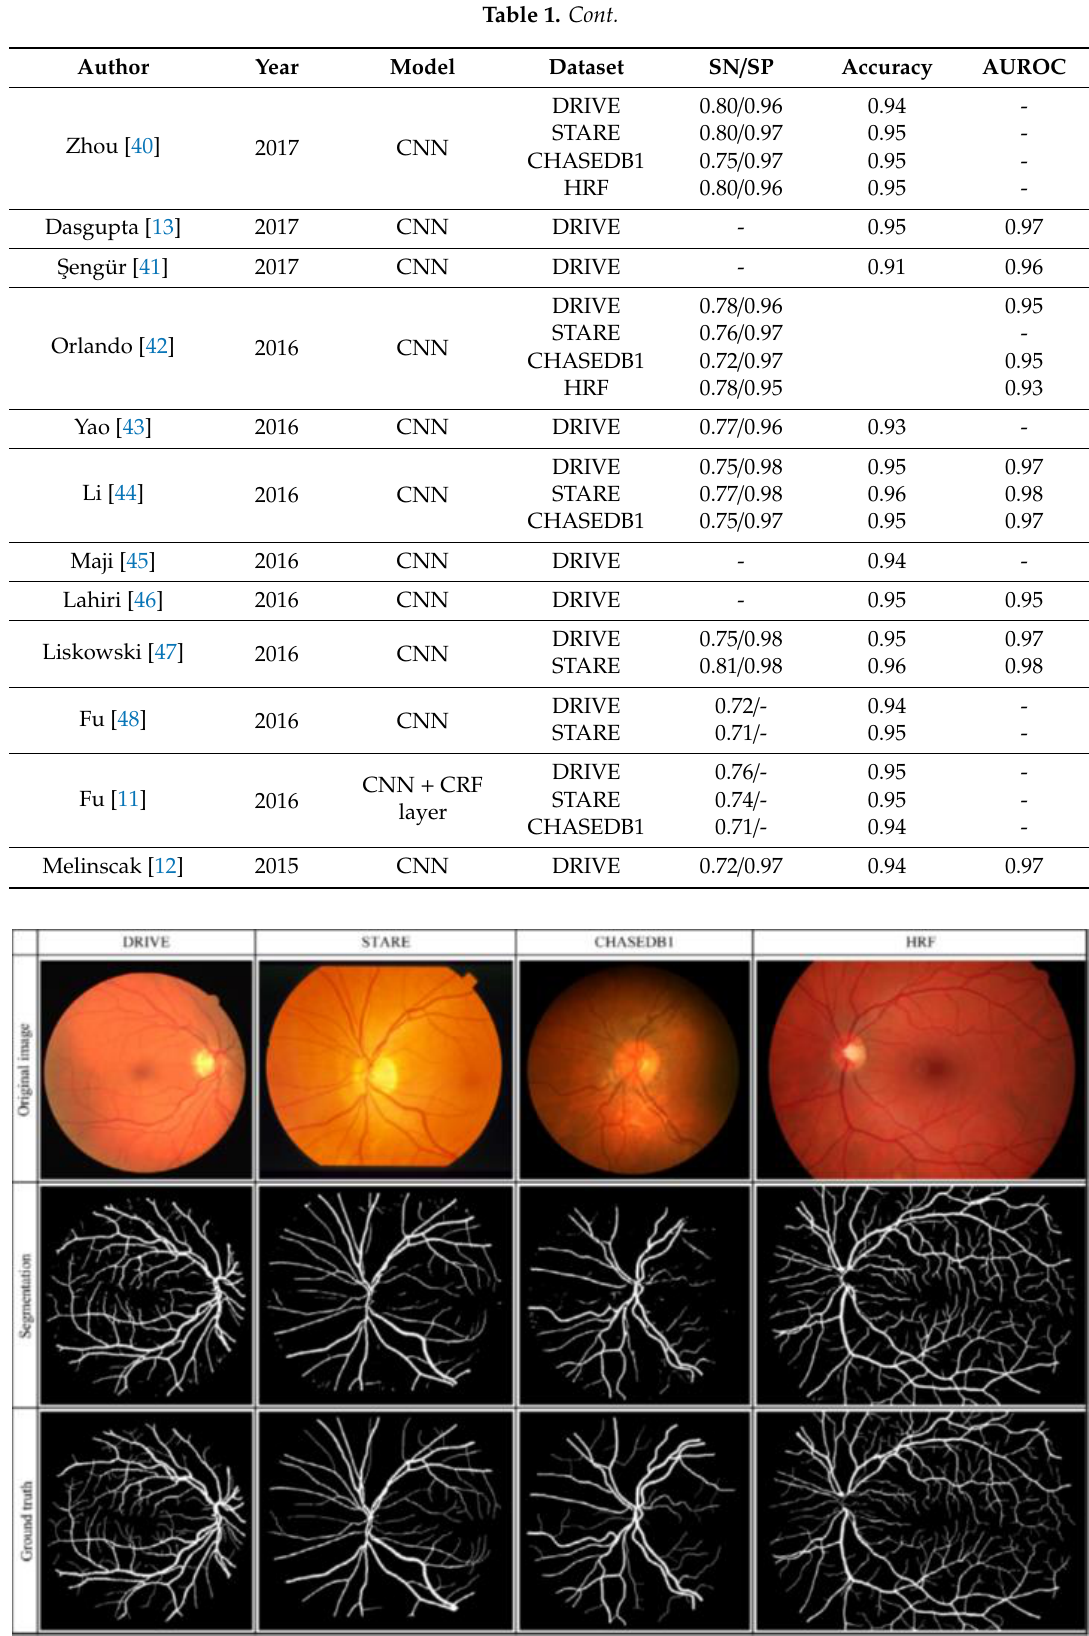
Figure 7. Original retinal, segmentation, and ground truth images in the four different databases. Table 1. Characteristic of included studies.